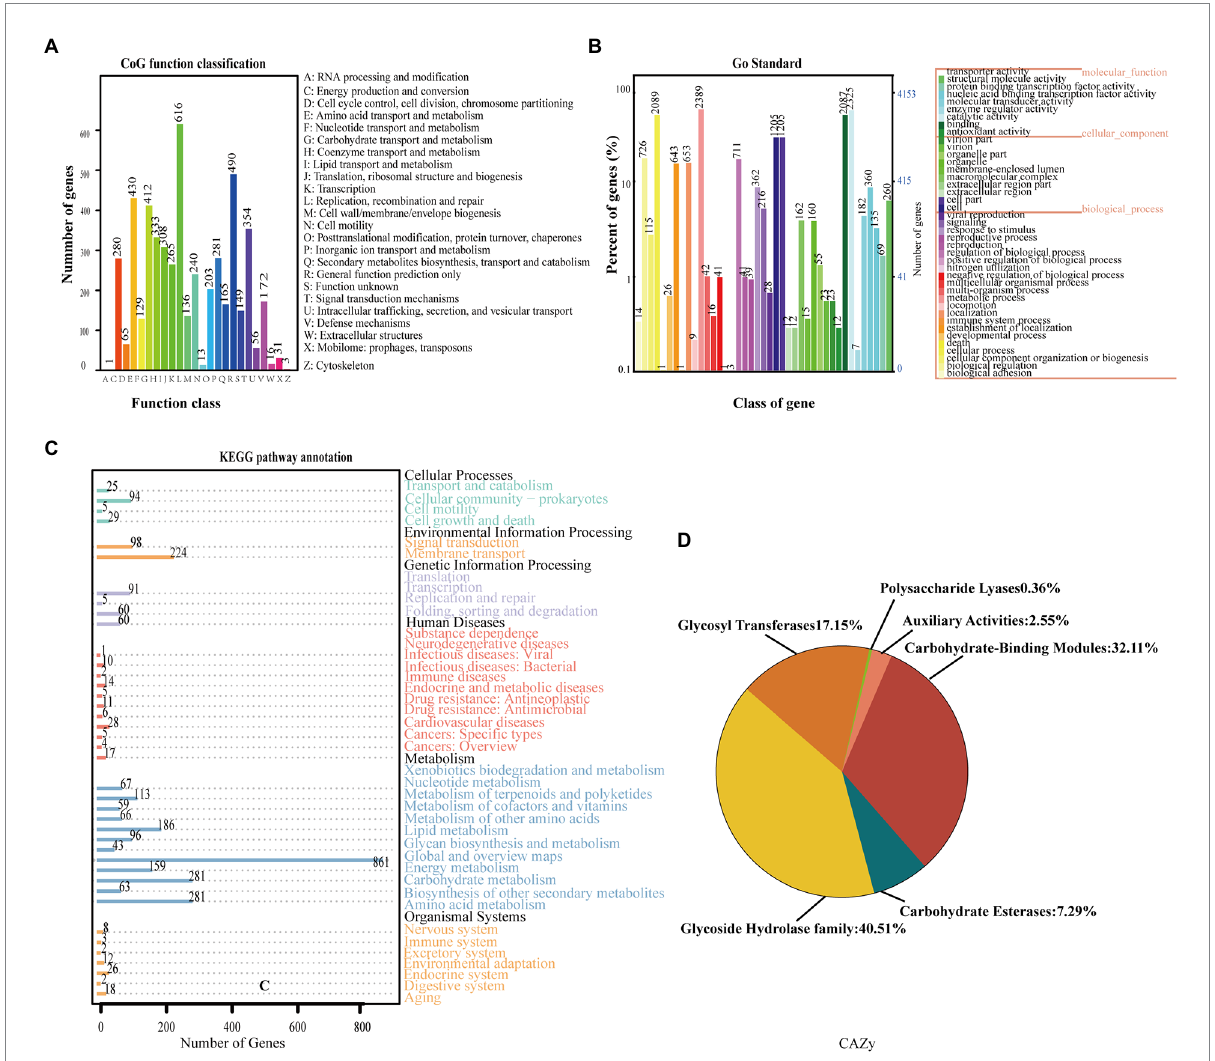
FIGURE 6 Analysis of genome structure and metabolic pathway of strain Streptomyces albidoflavus St-220. (A) COG annotation of strain St. albidoflavus St-220. genome. (B) GO functional categories of St. albidoflavus St-220. (C) Pathway annotation of strain St. albidoflavus St-220 genome according to the KEGG database. The vertical axis represented the level two classification of KEGG pathway. The horizontal axis represented the gene number annotated in this classification. Different colors of the columns represented different classifications of KEGG pathway. (D) Gene count distributions of carbohydrate-active enzyme (CAZy)